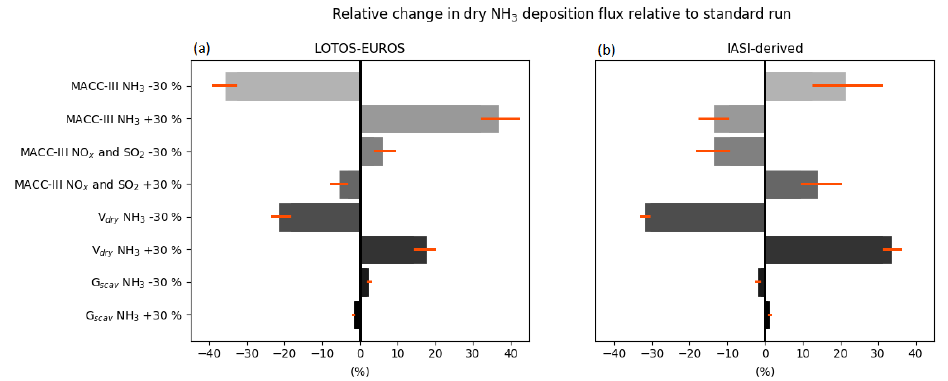
Figure 16. The median change (%) in the terrestrial NH 3 dry deposition flux in 2014 in (kgNha − 1 yr − 1 ) from LOTOS-EUROS (a) and IASI-derived fluxes (b) , resulting from different perturbations of model inputs of LOTOS-EUROS. The orange lines indicate the 25th and the 75th